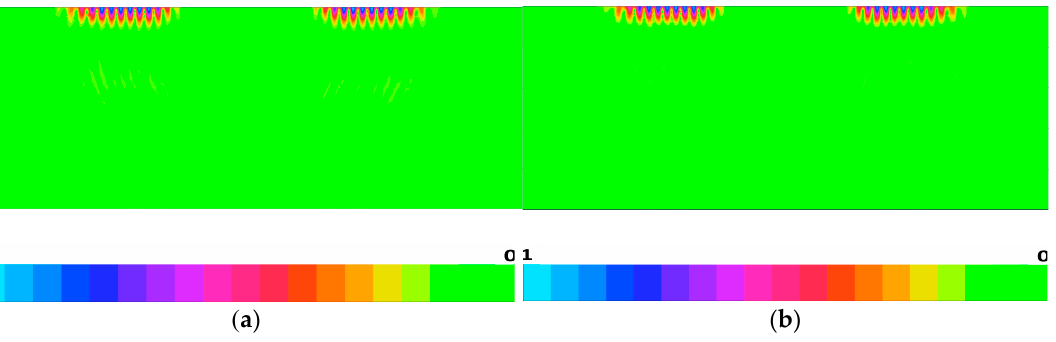
( b ) Figure 6. ( a ) Dependence of effective permittivity ε eff / ε 0 versus dimensionless slowness V Shear /V and ( b ) IDT conductance as a function of frequency for a homogeneous IDT having 100 Al electrodes with period λ = 20 μ m and electrode thickness h/ λ = 1% on the Z-cut and the pseudo-surface wave propagation direction along the crystal X-axis. The normalized absolute values of SAW and pseudo-SAW displacements generated by the IDT consisting of five electrode pairs with periodicity 20 μ m in the uniform IDT are illustrated in Figure 7. The transducer is located at the center on the top of Figure 7a,b. The generation source was a harmonic voltage signal with the duration of two periods. For the Z-cut and the wave propagation direction along the crystal X + 70°-axis, the pe- riod was taken equal to 1/f 0 = 1/200 MHz (see Figure 5b). For the pseudo-surface wave propagation direction along the X-axis, it was taken equal to 1/f 0 = 1/197 MHz (Figure 6b). Here, f 0 is the frequency of the maximum IDT conductance value in Figures 5 and 6, re- spectively. It is shown in Figure 6a,b that the excitation of SAW and pseudo-SAW by the